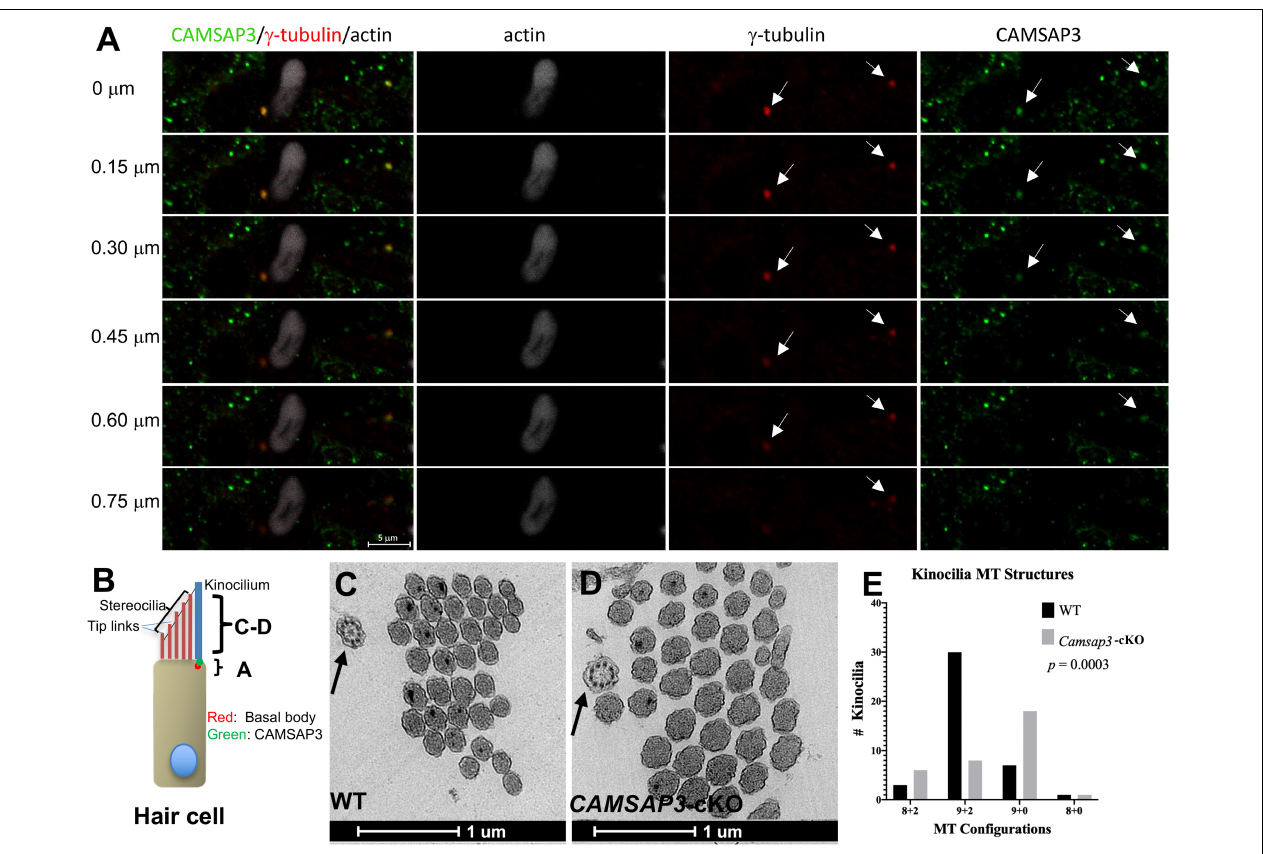
FIGURE 3 | CAMSAP3 contributes to the formation of central MT pairs in axonemes of kinocilia on utricle hair cells. (A) The overlaps between CAMSAP3 (green) and basal bodies (red) were displayed by a group of consecutive Z-stack kinocilia images taken from a whole mount utricle sample of WT (P42). Z-stack images were captured using the optical section (0.5 µ m) starting from the apical surface of utricle hair cells toward its nucleus. Antibodies: anti-CAMSAP3 (Green), anti- γ -tubulin (red), phalloidin (white). Scale Bars = 5 µ m. Two basal bodies of kinocilia were indicated by arrows. (B) A schematic diagram illustrates the region over which Z-stack images of kinocilia immunostaining A, and TEM images C-D were collected. (C,D) Representative TEM images show transverse sections of kinocilia on utricle hair cells from 8-month-old WT with a “9+2” configuration (black arrow) (C) , and a “9+0” configuration (black arrow) for their Camsap3 -cKO littermates (D) . Scale Bars = 1 µ m. (E) The distribution of MT arrangements for both WT and Camsap3 -cKO mice was compared. Distribution of the MT configurations between WT and KO was significantly different as analyzed by a Kolmogorov–Smirnov test ( p =